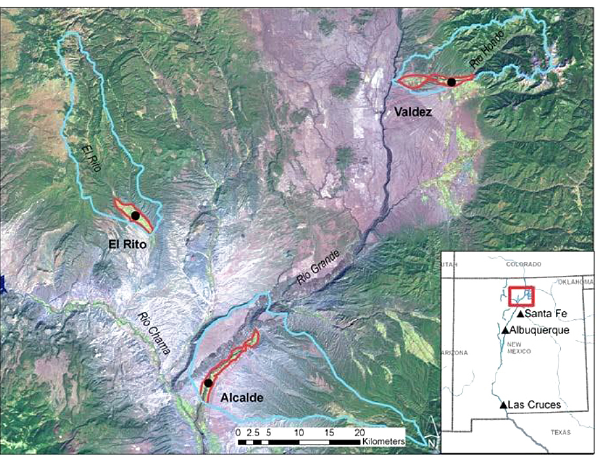
2 Resilience due to irrigation seepage